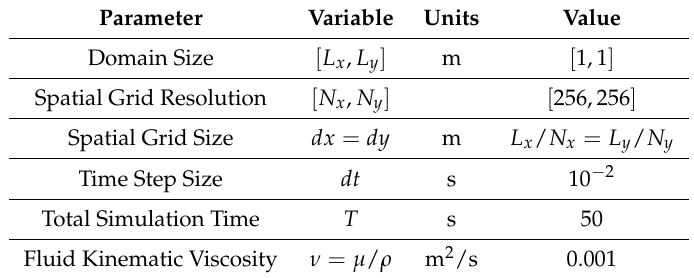
Table 6. Numerical parameters for case of evolving vorticity from an initial velocity